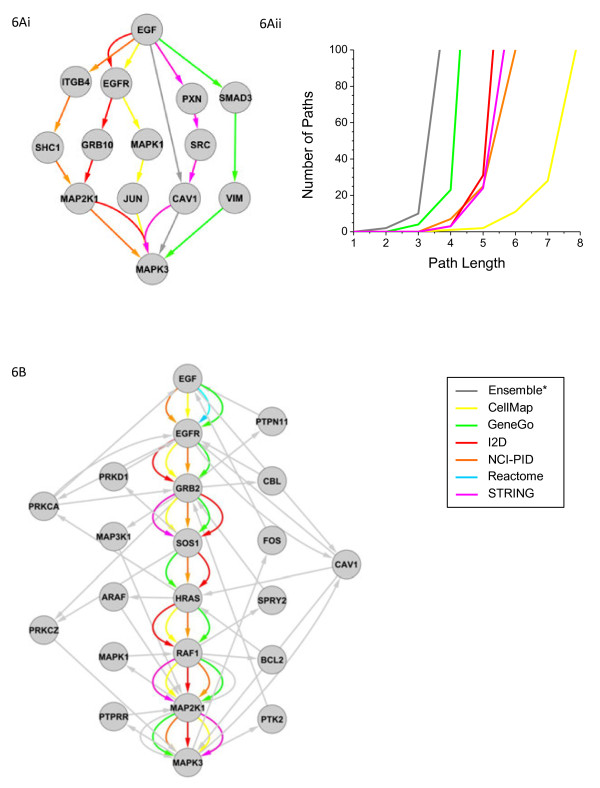
Ensemble representation of EGF signalling network. Alternate signal transmission routes connecting the extracellular ligand EGF to the sentinel marker of pathway activity MAPK3 (ERK). Shortest paths (Ai), and total number of paths as a function of path length (Aii), color-coded by database source. (B) The “consensus” linear EGF pathway, with edges color-coded by source, plus additional connections through the ensemble network color-coded grey. Note the Ensemble network edges are derived from multiple sources, with all connections in the consensus pathway represented in at least 3 different databases.